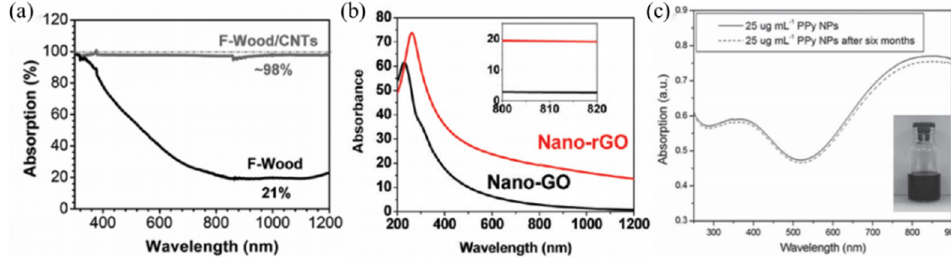
Figure 10. ( a ) Light absorption spectra for the F-Wood and F-Wood/CNTs membranes